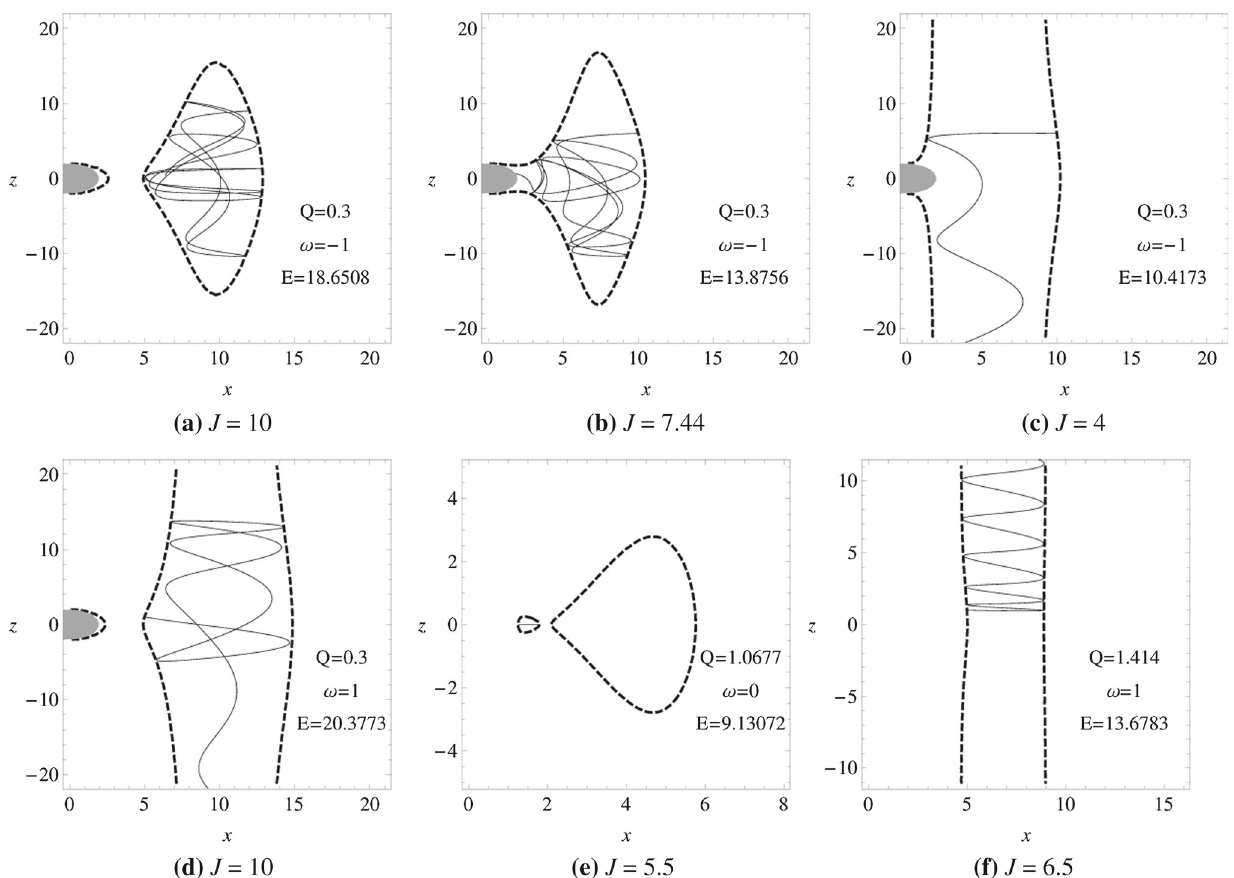
Fig. 6 (prepsat) Trajectories of the string loop and energy boundaries of their motion. Four various types of motion possible: trapped in some “lake”-like region ( a , e ), capture by black hole ( b ), collapse or escape to infinity ( c ), escape to infinity ( d , f )